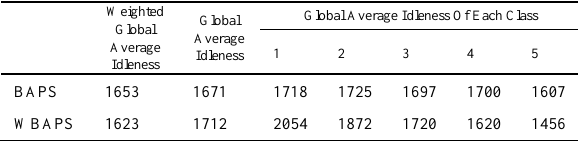
Table 6. Simulation result of BAPS and WBAPS (all values in